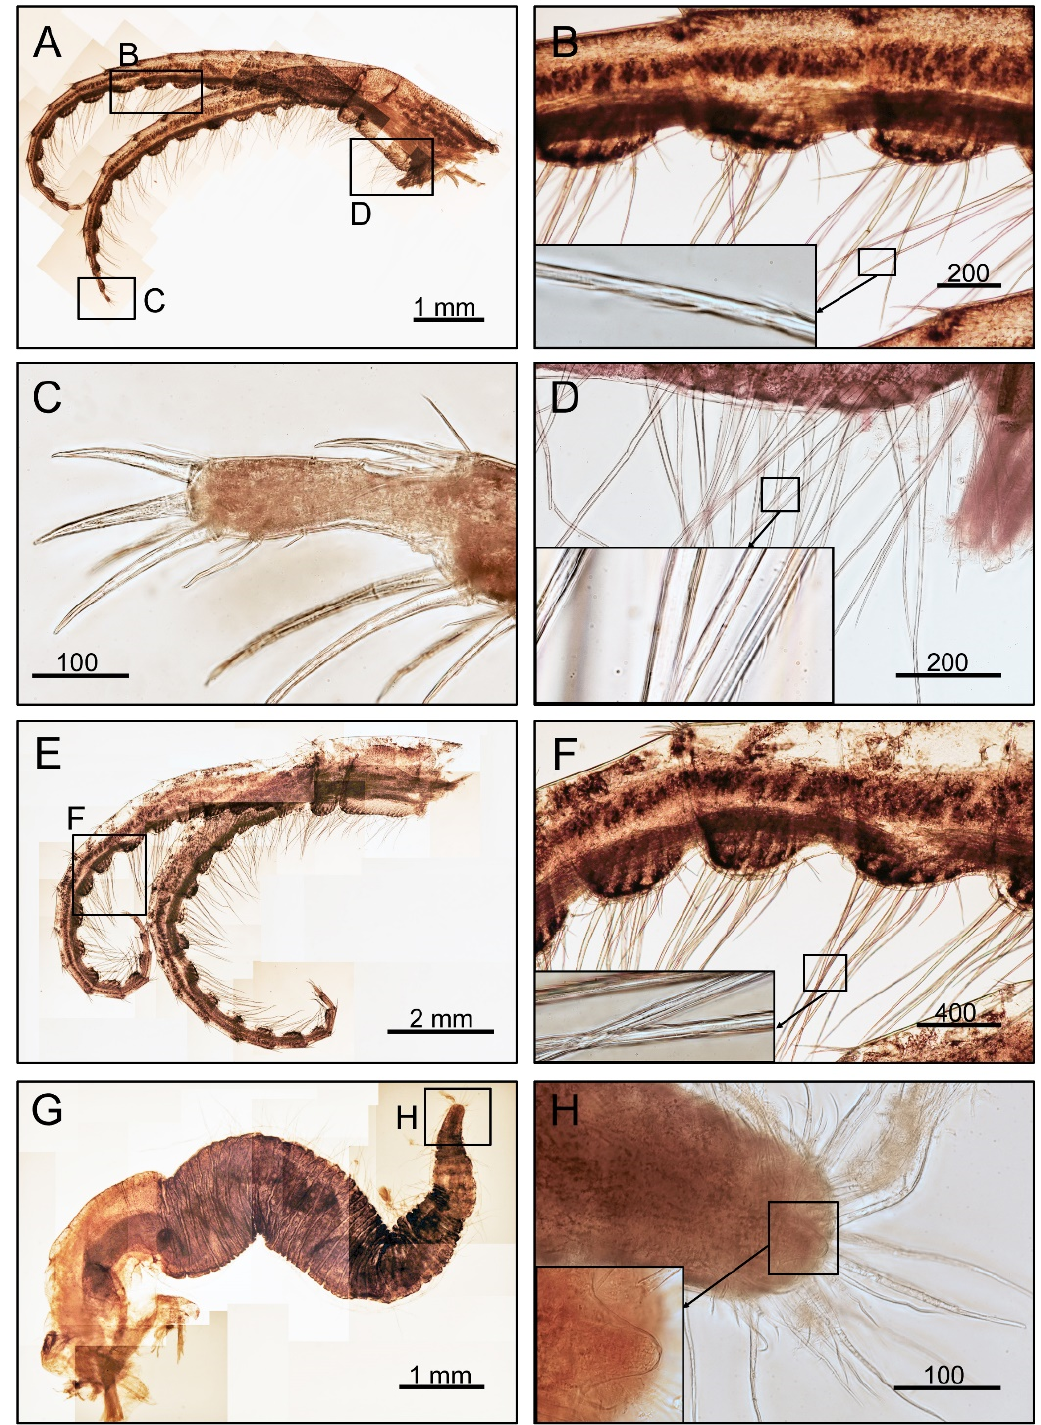
Figure 9. Conchoderma hunteri. ( A ) Cirrus V. ( B ) Intermediate segment of cirrus V showing serrulate setae. ( C ) Distal segment of cirrus V, showing robust simple setae. ( D ) Intermediate segment of cirrus V showing serrulate setae. ( E ) Cirrus VI. ( F ) Serrulate setae at intermediate segment of cirrus VI. ( G ) Penis. ( H ) Apex of penis. Scale bars in μ m.